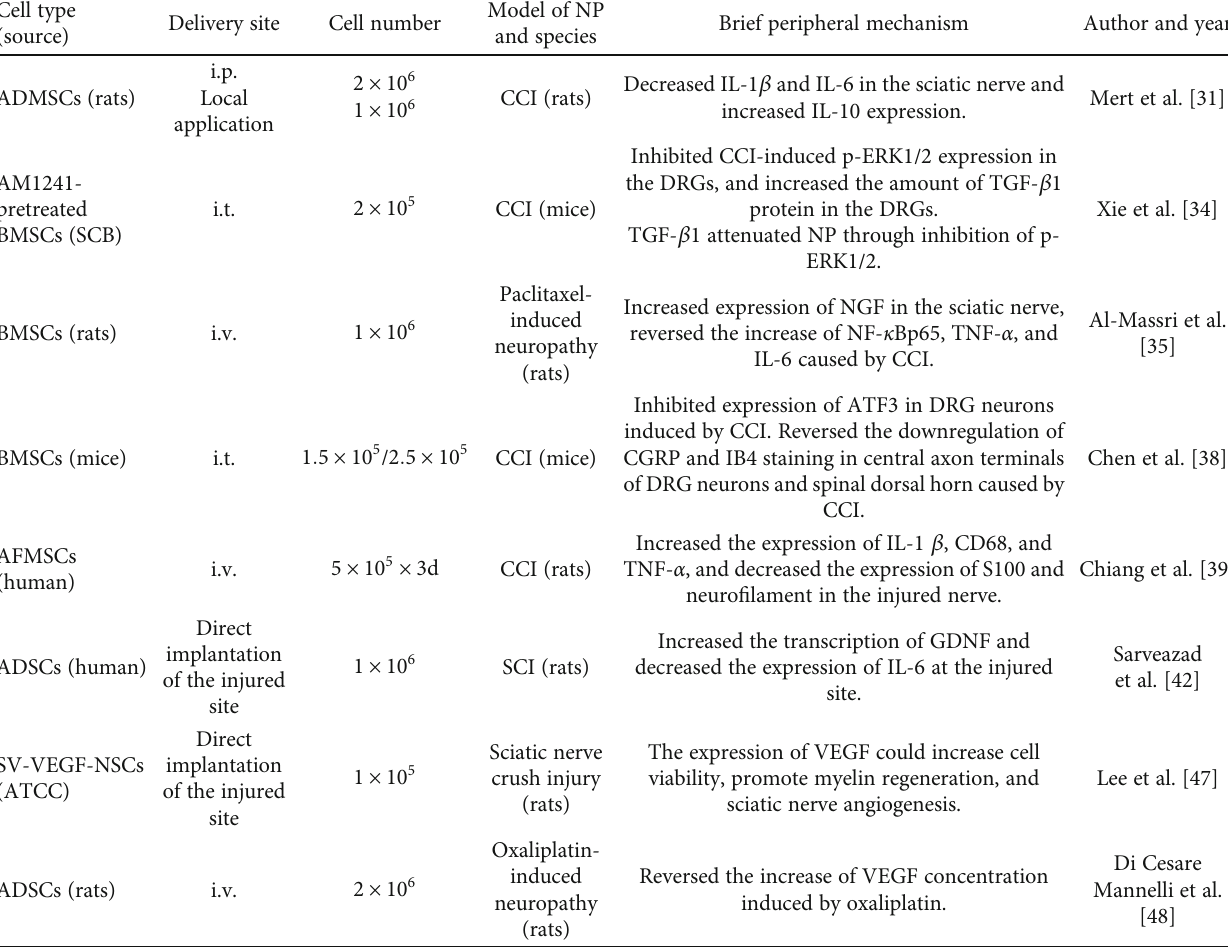
Table 2: Preclinical study of stem cells involved in peripheral mechanism in the treatment of neuropathic